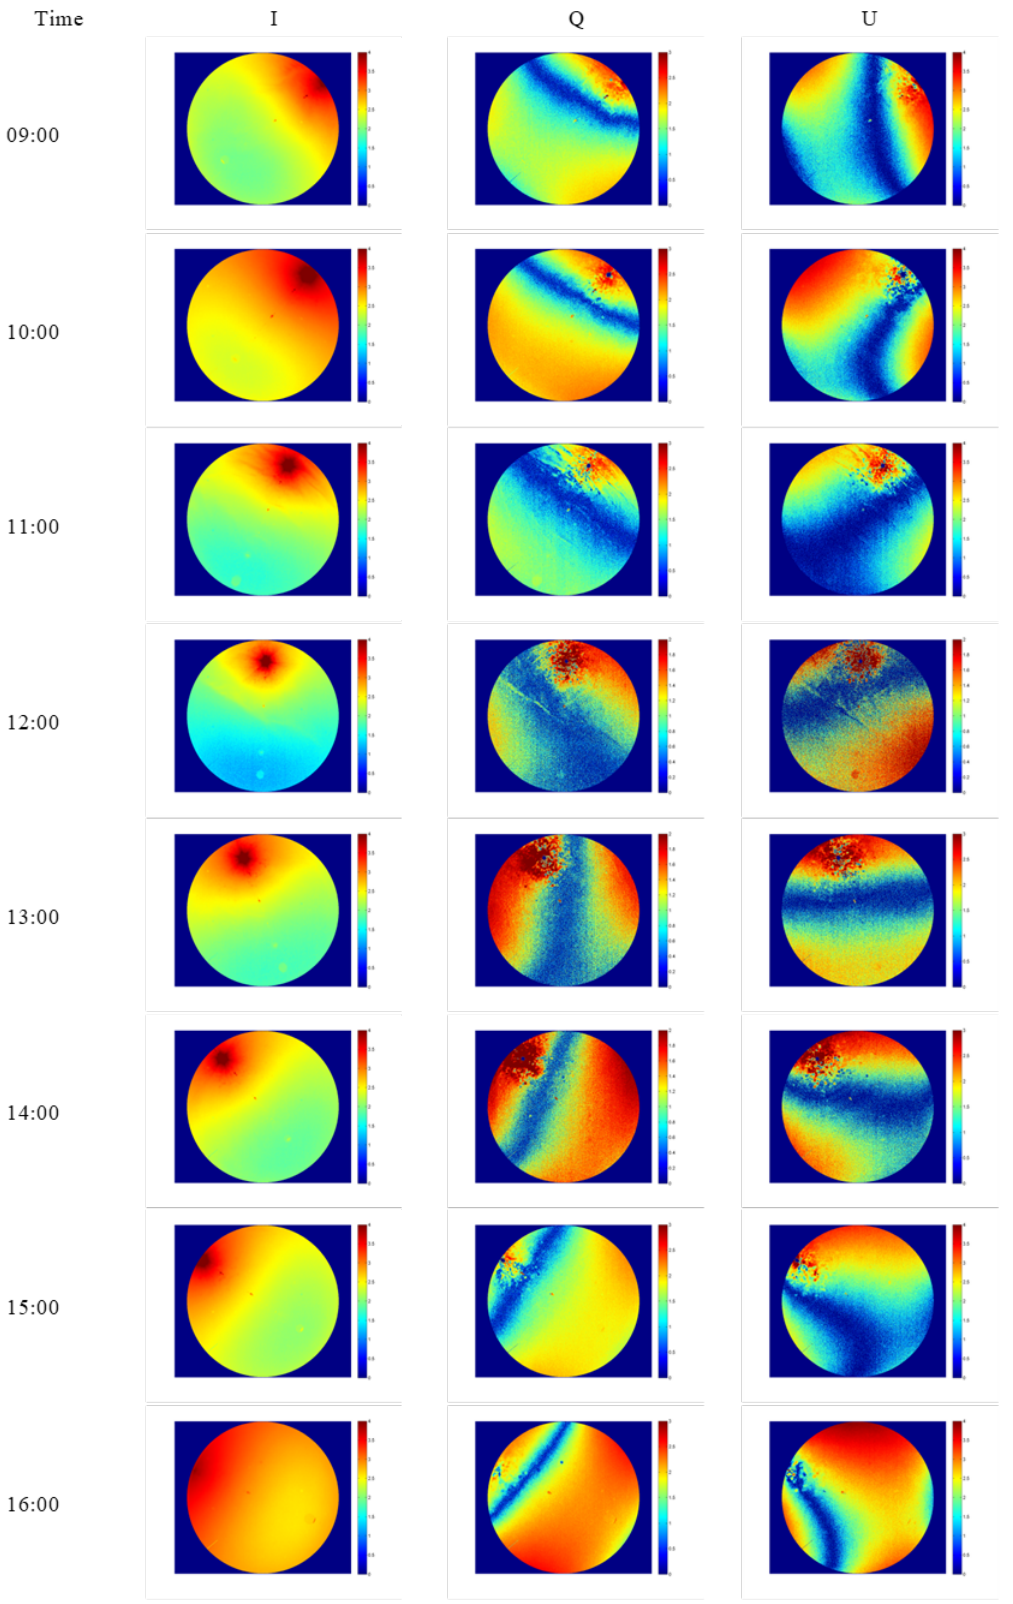
Figure 2. Daily variation of Stokes component of skylight (March 13, 2019, Peking